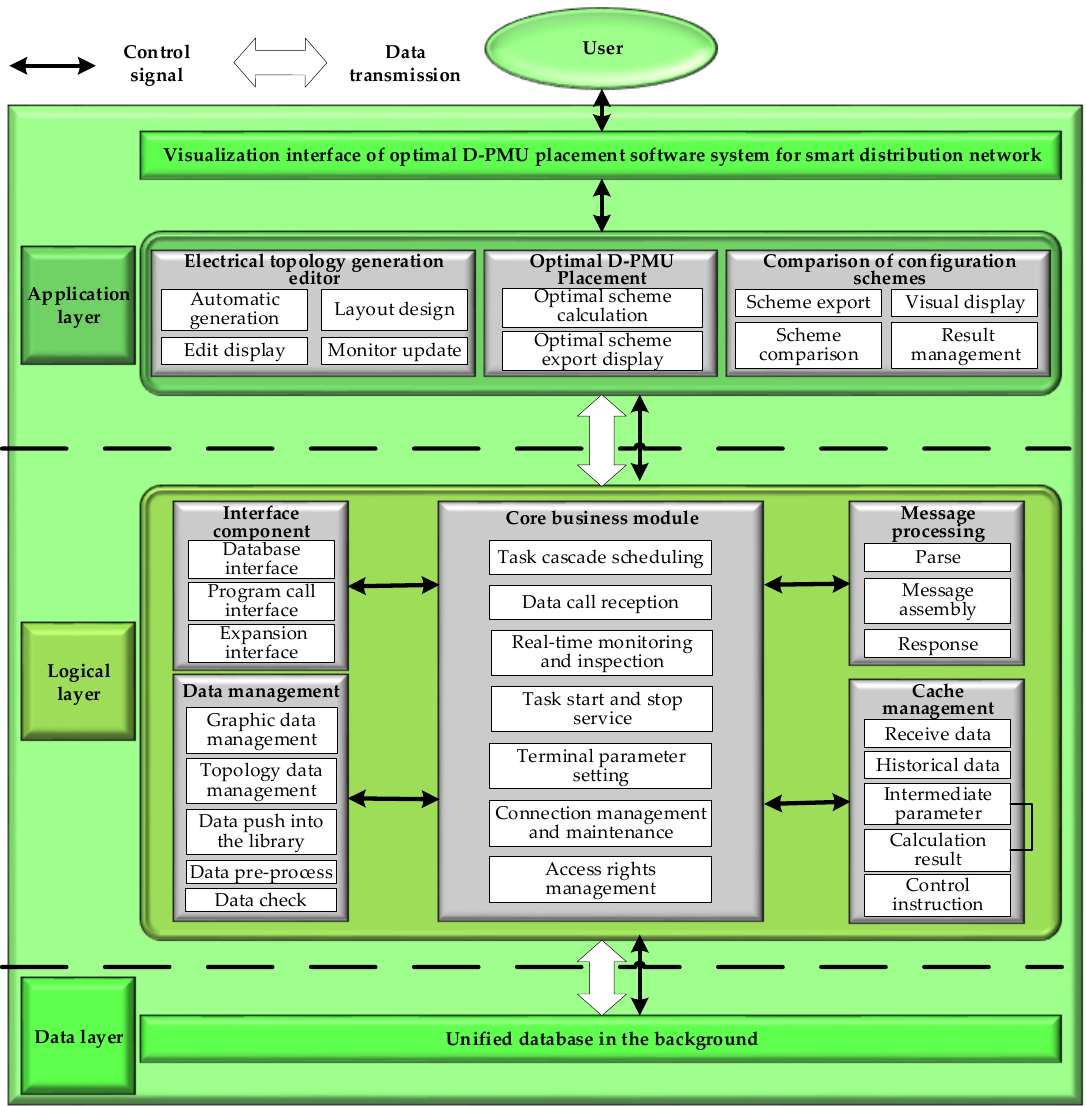
Figure 5. System functional architecture diagram.